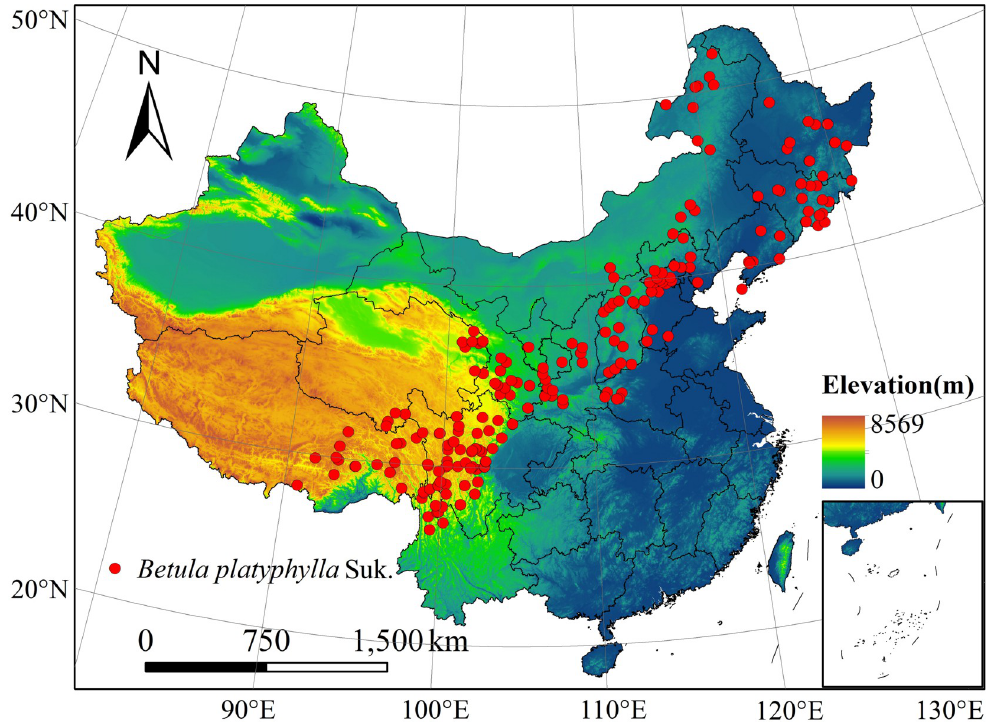
Fig 1. Distribution records of Betula Platyphylla Suk. in China. DEM was obtained from National Tibetan Plateau Data Center (http://data.tpdc.ac.cn). Reprinted from http://data.tpdc.ac.cn under a CC BY license, with permission from National Tibetan Plateau Data Center, original copyright [2019]. The boundary was obtained from Natural Earth (http:// www.naturalearthdata.com/). Based on the principle of national and territorial integrity, we have modified and adjusted the vector